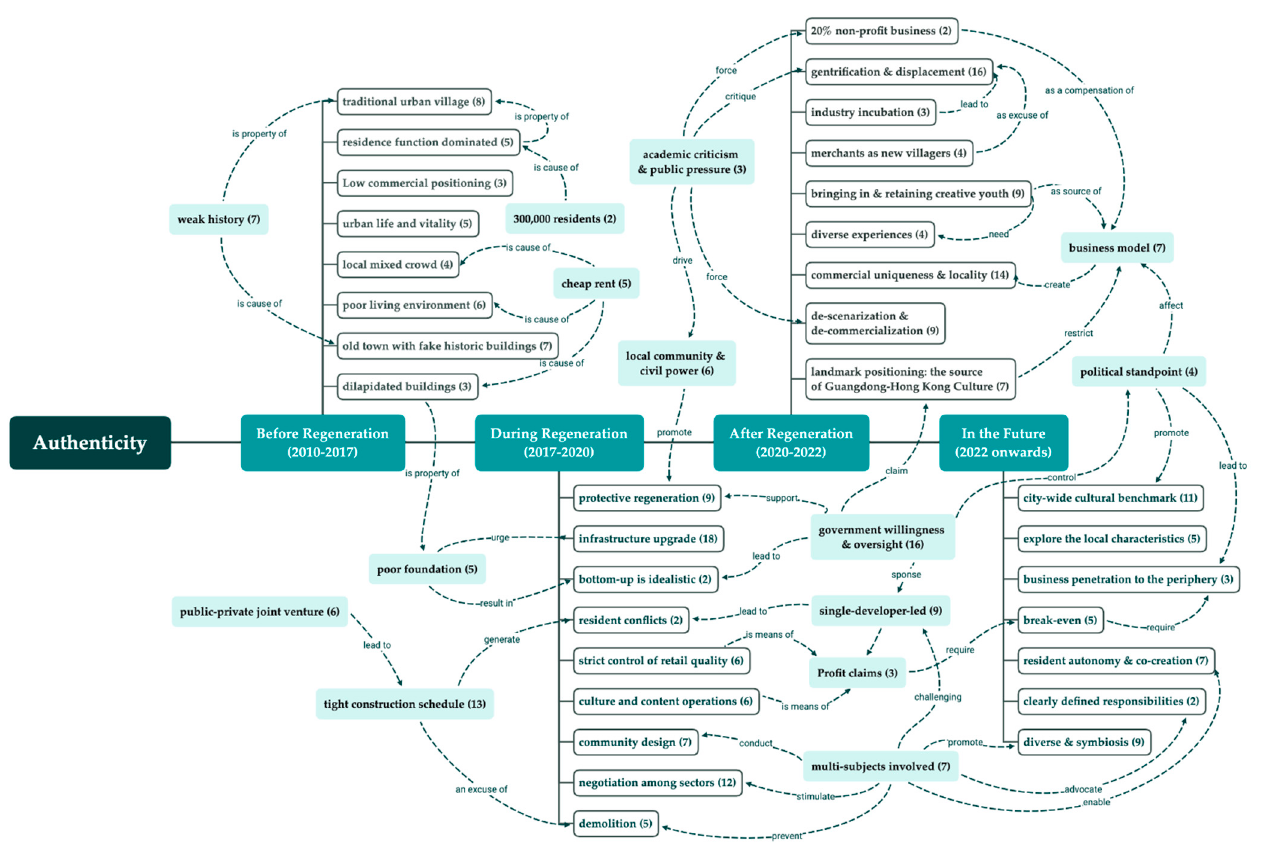
Figure 6. Codes related to authenticity in describing different regeneration phases with attributing factors and term frequencies.